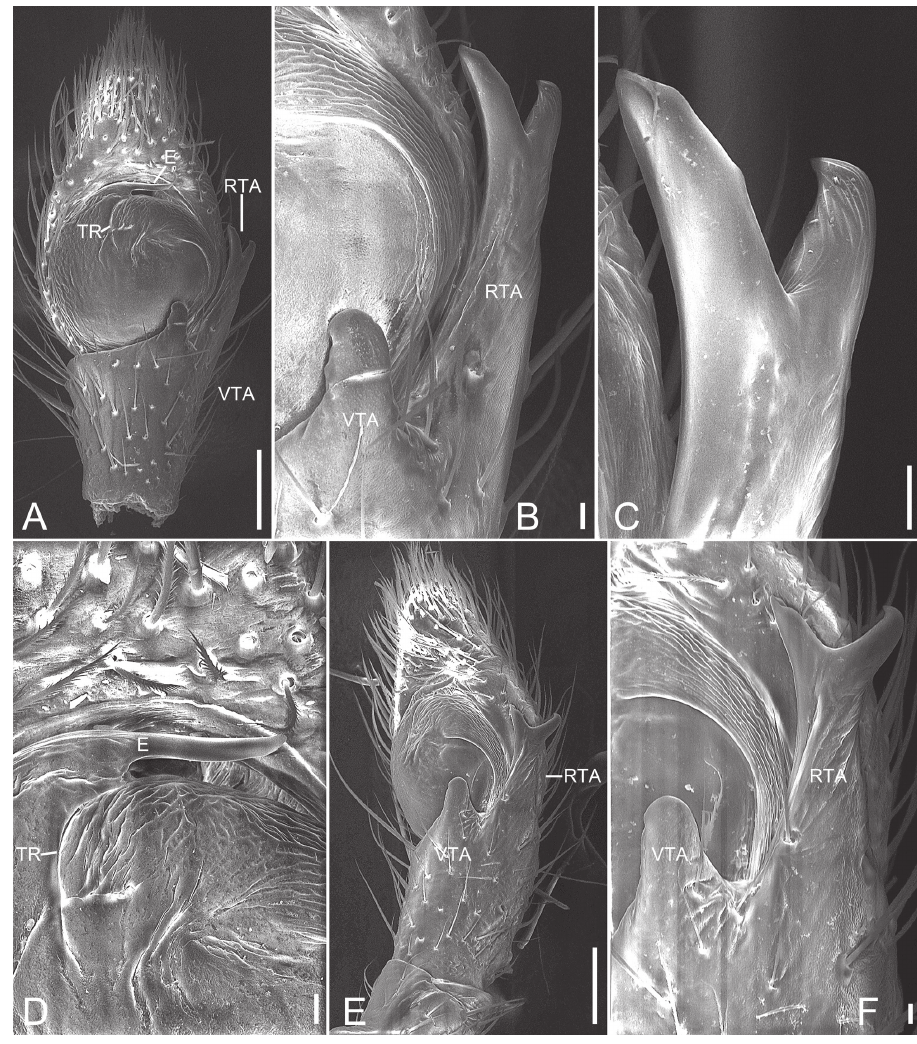
Figure 5. SEM micrographs of Ebelingia forcipata (Song & Zhu, 1993) comb. nov., male palp. A ventral view B same, details of tibial apophysis C same, details of retrolateral tibial apophysis D same, details of embolus E retrolateral view F same, details of tibial apophyses. Abbreviations: E – embolus, RTA – ret- rolateral tibial apophysis, TR – tegular ridge, VTA – ventral tibial apophysis. Scale bars: 0.1 mm ( A, E ), 10 μm ( B, C, D, F